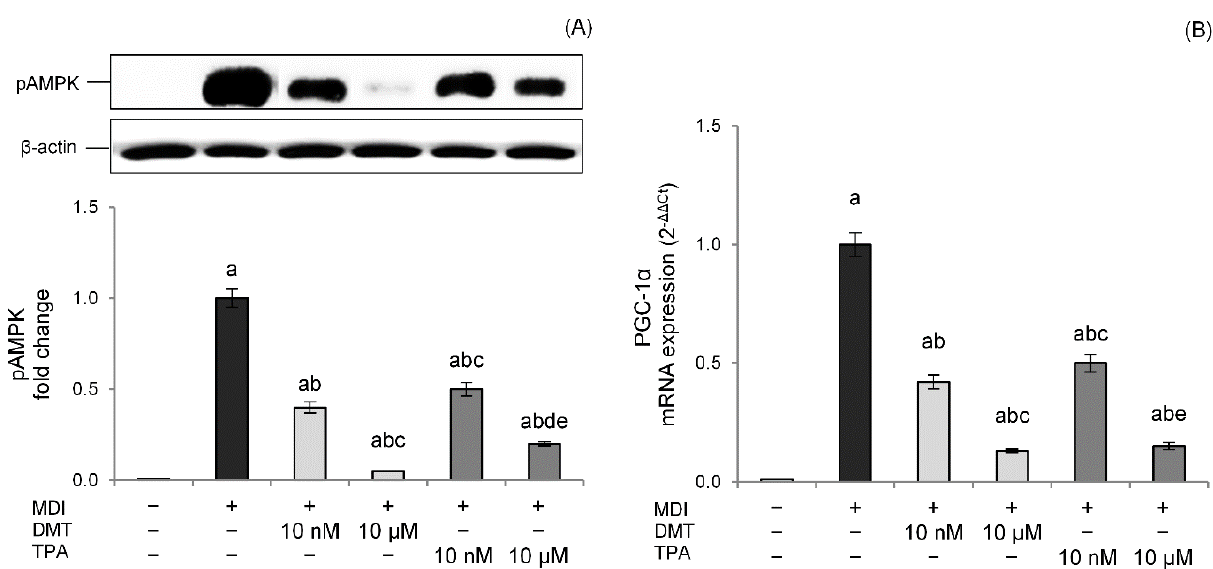
Figure 6. Effects of p-phthalates on pAMPK expression ( A ) and PGC1 α gene expression ( B ). 3T3–L1 preadipocytes were cultured in differentiation medium (MDI) containing p-phthalates (10 nM and 10 µ M) for 10 days. Cells treated with MDI alone were used as controls. Undifferentiated cells were cultured in standard medium for 10 days. The densitometry results are reported as fold change compared to MDI. The intensity values of the pAMPK protein were normalized to the corresponding value of β -actin ( A ). PGC1 α gene expression values ( B ) are expressed as 2 − ∆∆ Ct and normalized against MDI. 18S rRNA was used as housekeeping gene. All data are expressed as mean ± SD of three independent experiments. a p < 0.05 vs. undifferentiated cells; b p < 0.05 vs. MDI; c p < 0.05 vs. DMT 10 nM; d p < 0.05 vs. DMT 10 µ M; e p < 0.05 vs. TPA 10 nM.